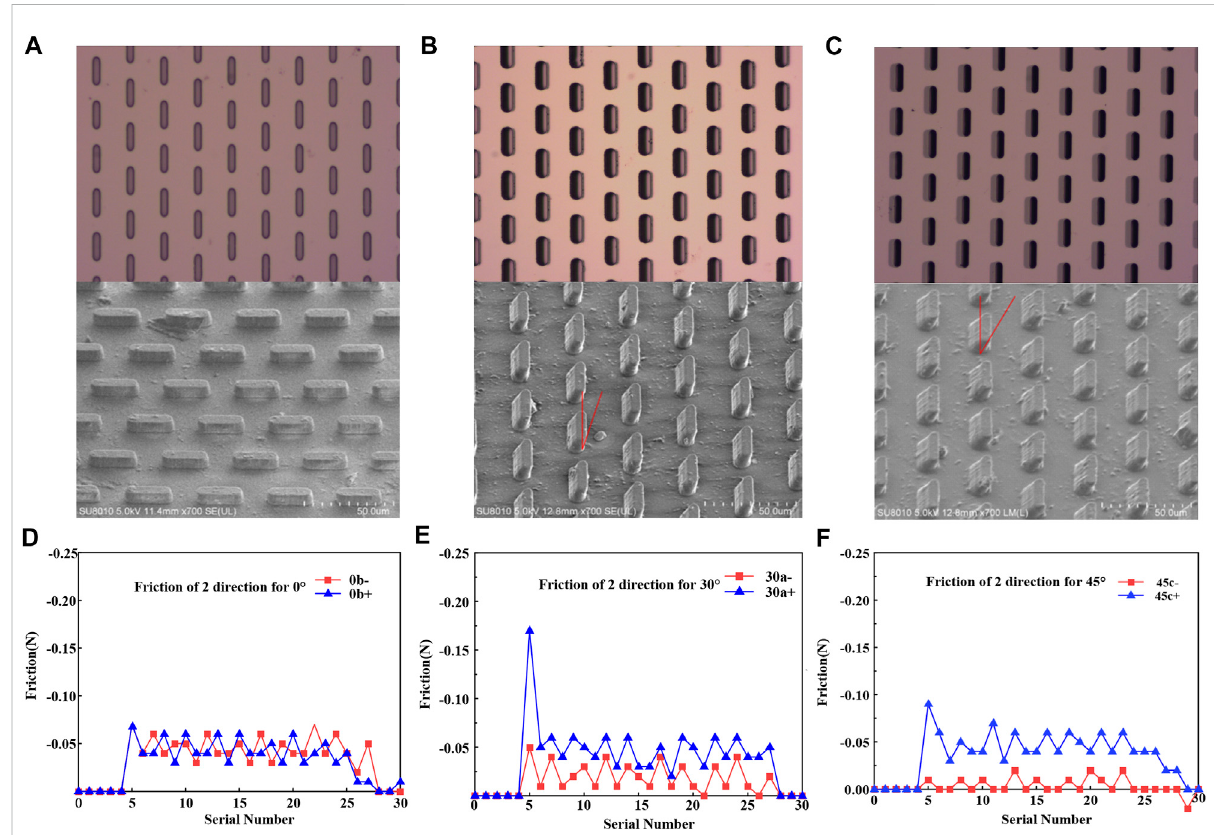
FIGURE 6 Images of the tilted fi sh-scale-like microstructures and their anisotropic friction curves at various angles. (A – C) : Top half of the fi gure: optical microscope diagram of the mold of the tilted fi sh-scale-like microstructures with inclined angles of 0 ° , 30 ° , and 45 ° ; lower half of the fi gure: SEM images of the inclined fi sh-scale-like microstructures samples with inclined angles of 0 ° , 30 ° , and 45 ° . (D – F) : The friction force of the samples with inclined angles of 0 ° , 30 ° , and 45 ° when dragging along the fl ake structure ( ▲ ) and against the fl ake structure ( ■